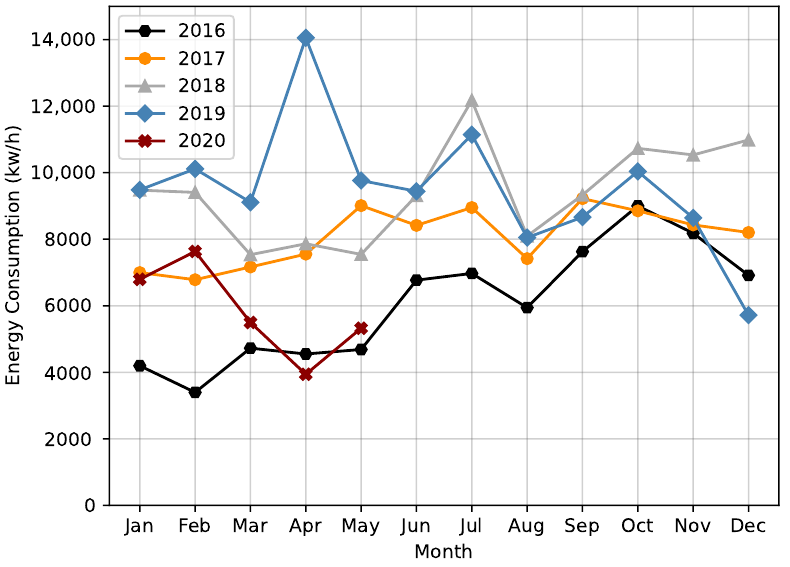
Figure 2. Monthly variation of energy consumption over the years present in the dataset.